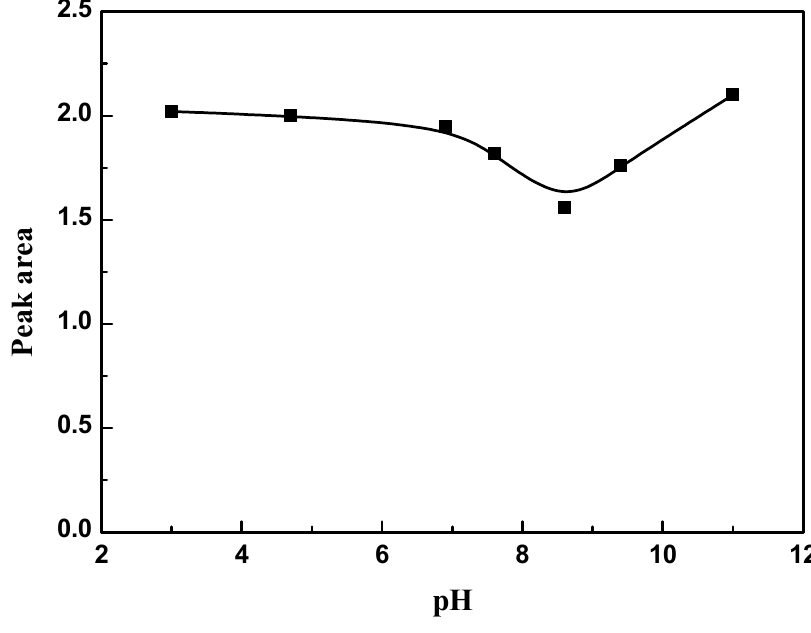
Figure 5. Effect of pH on the adsorption of Tyr amino acid on the GO’s surface.